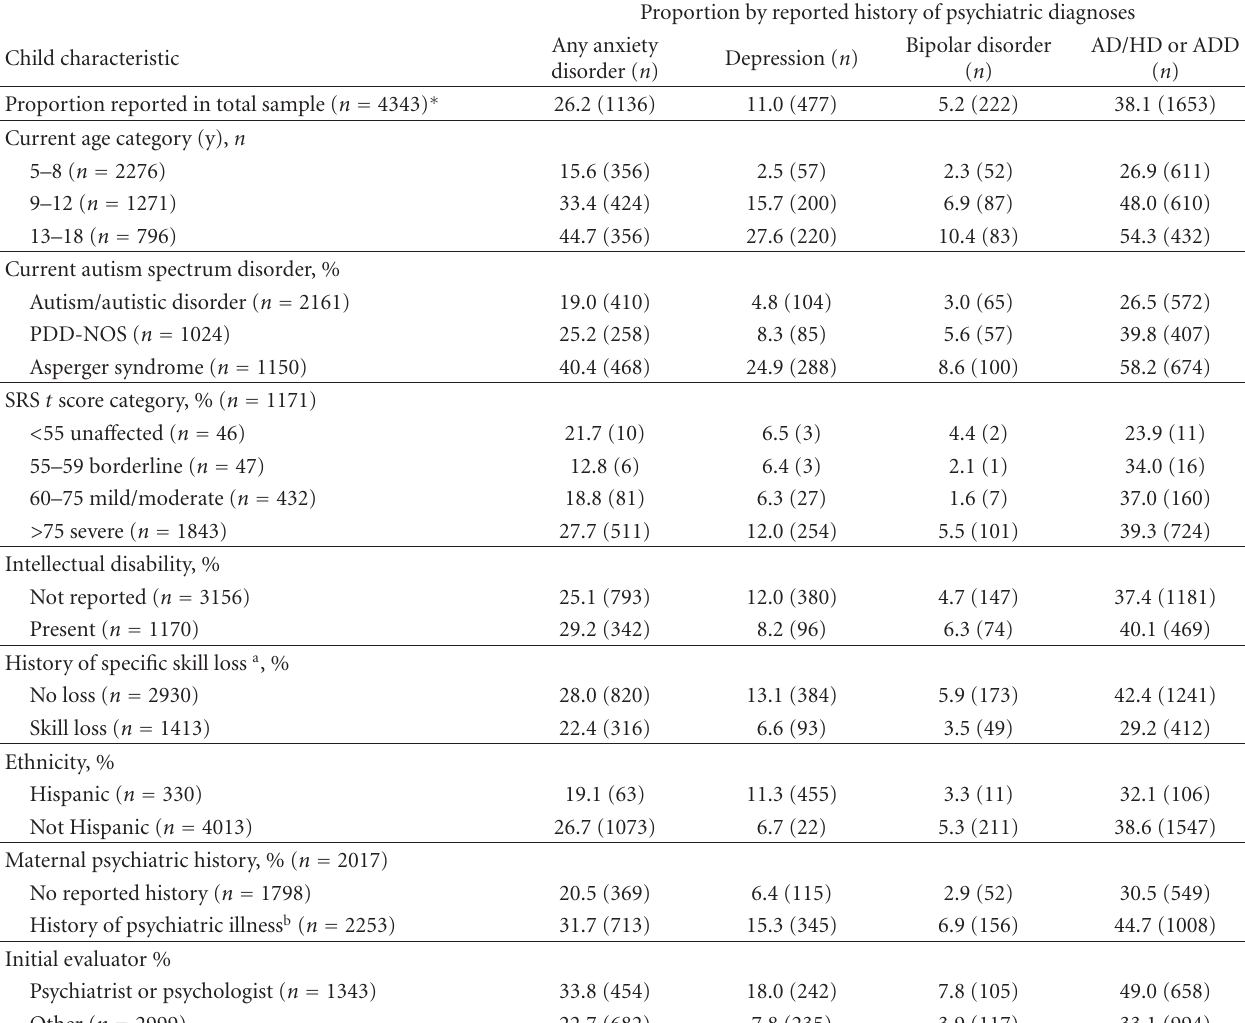
Table 2: Characteristics of children with ASD by presence of ≥ 1 psychiatric comorbidity, aged 5–18 y, significantly di ff erent from peers without particular comorbidity ( P < . 01 by chi-square).